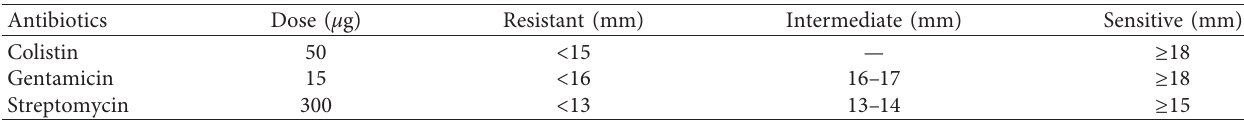
Table 1: Phenotypic characterization of the antibiotic resistance of Escherichia coli ATCC ® 25922 ™ strains according to the diameter of inhibition (mm) of three antibiotics